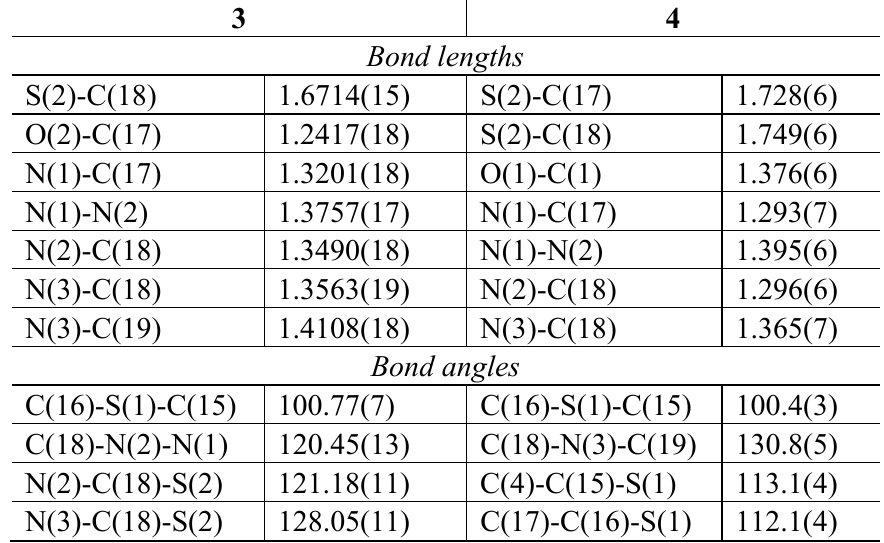
Table 1. Selected bond lengths [Å] and bond angles [°] for 3 and 4 .